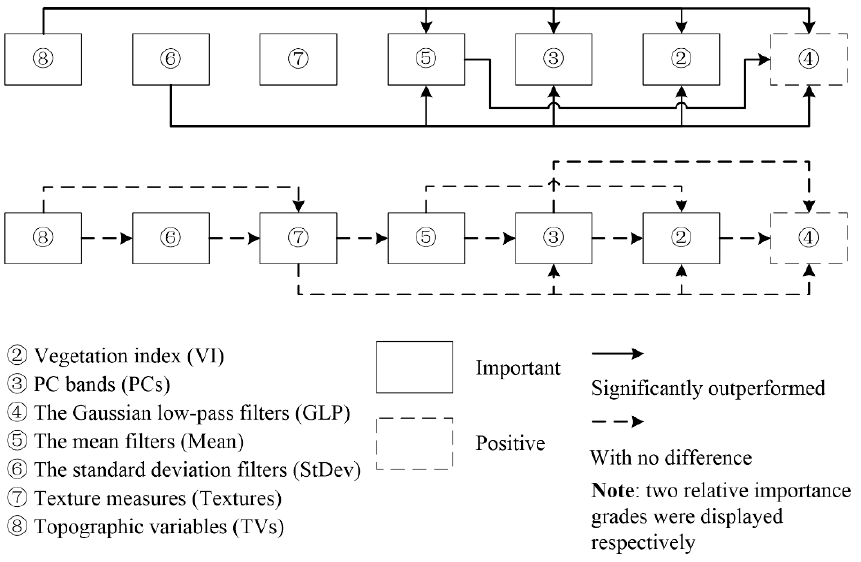
Figure 4. The importance grade and relative importance of feature sets.